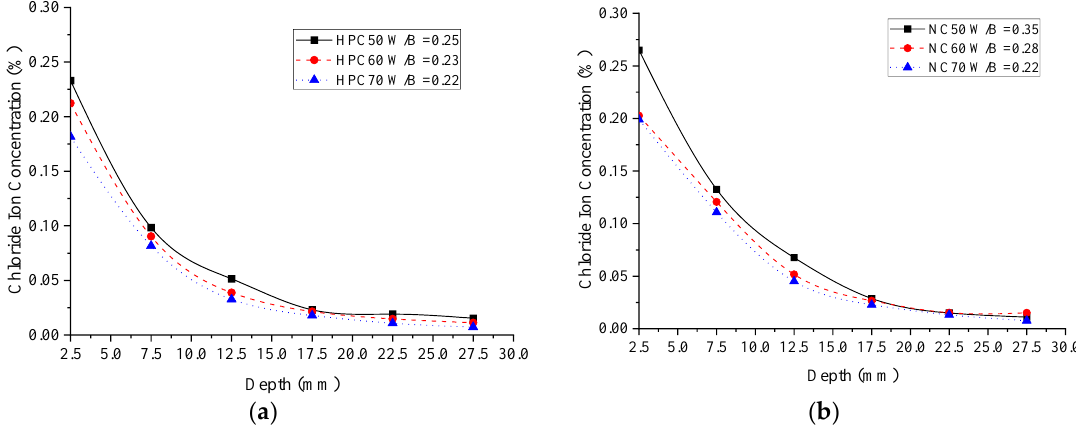
Figure 4. Chloride ion concentration of the specimens: ( a ) Normal concrete; ( b ) HPC.